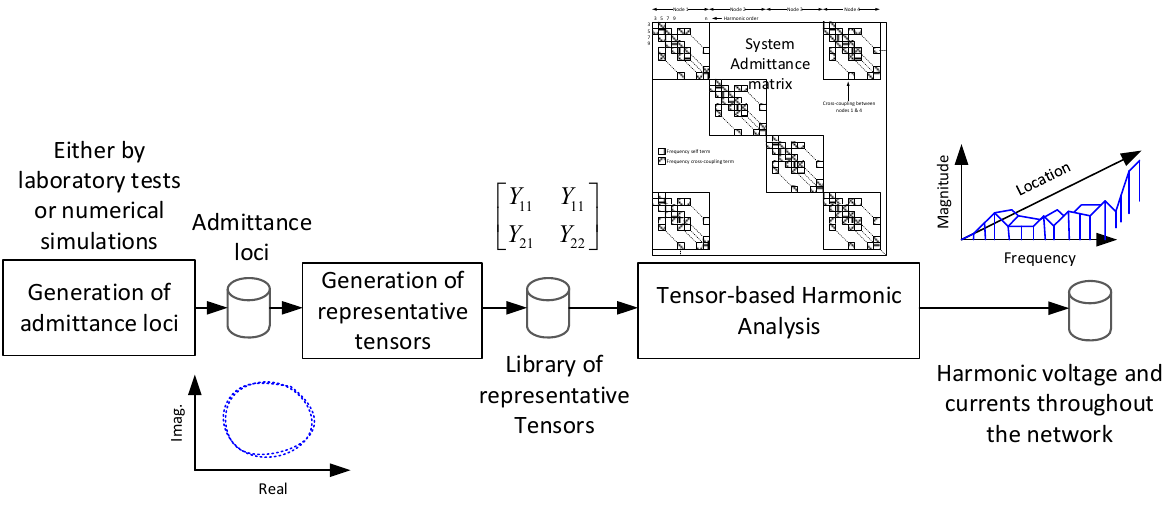
Figure 5. Tensor-based analysis framework.